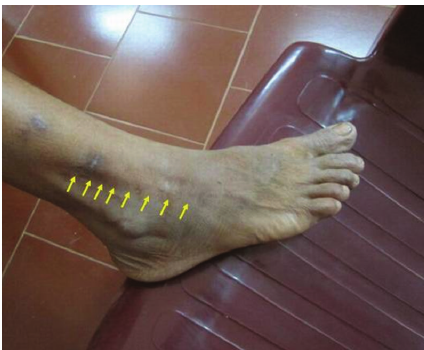
Figure 4: (Case 1): skin biopsy, perivascular lymphocytic infiltrate only. (H&E × 100).